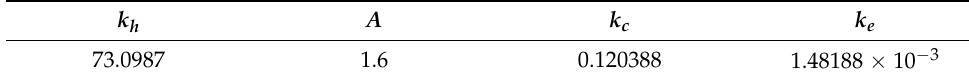
Figure 8. Loss curves of the silicon sheet with a sinusoid supply. Table 4. Direct fitting results of parameters for silicon steel